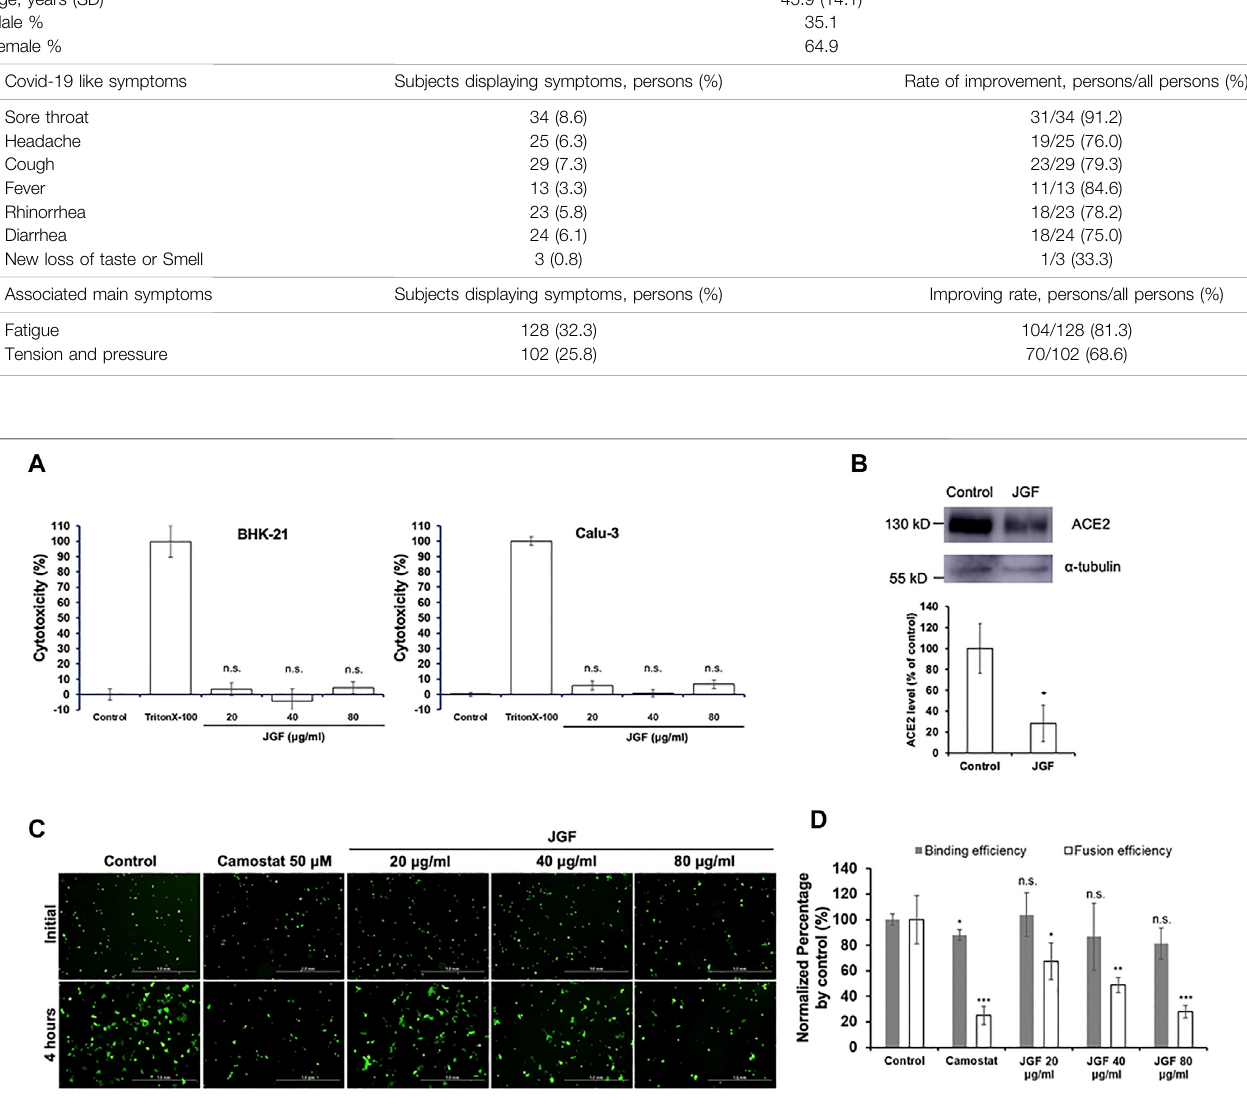
Frontiers in Pharmacology |